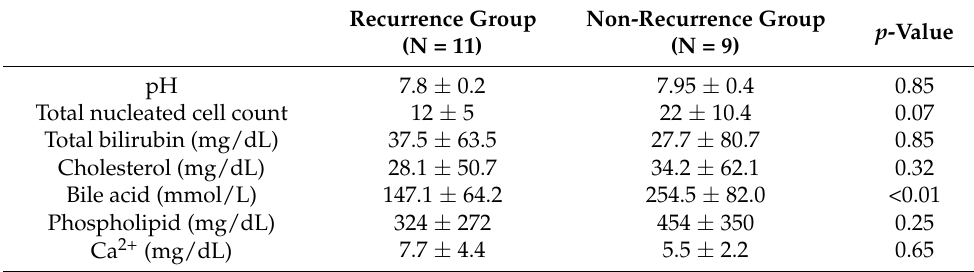
Table 4. Bile metabolic